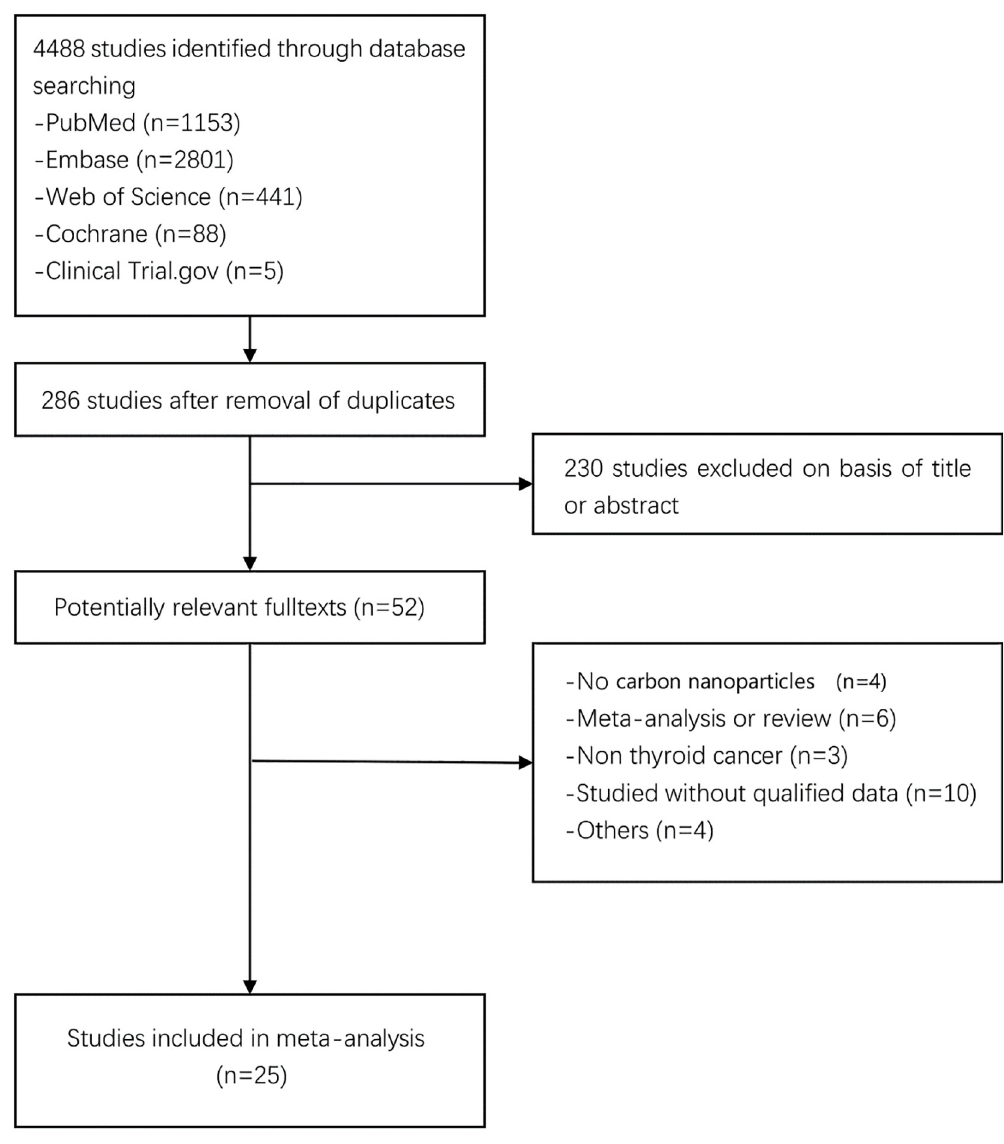
Fig 1. Study flow